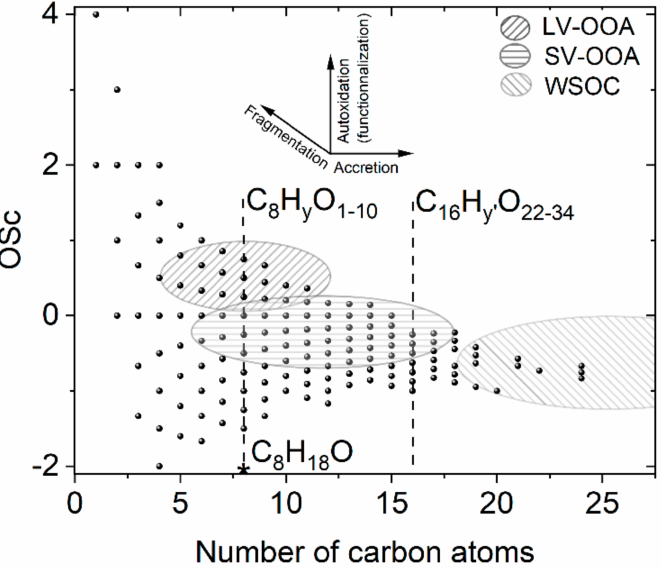
Figure 10. Variation of the OSc as a function of the number of carbon atoms in molecular formulae detected by negative APCI FIA-HRMS of a DBE oxidation sample collected at 540